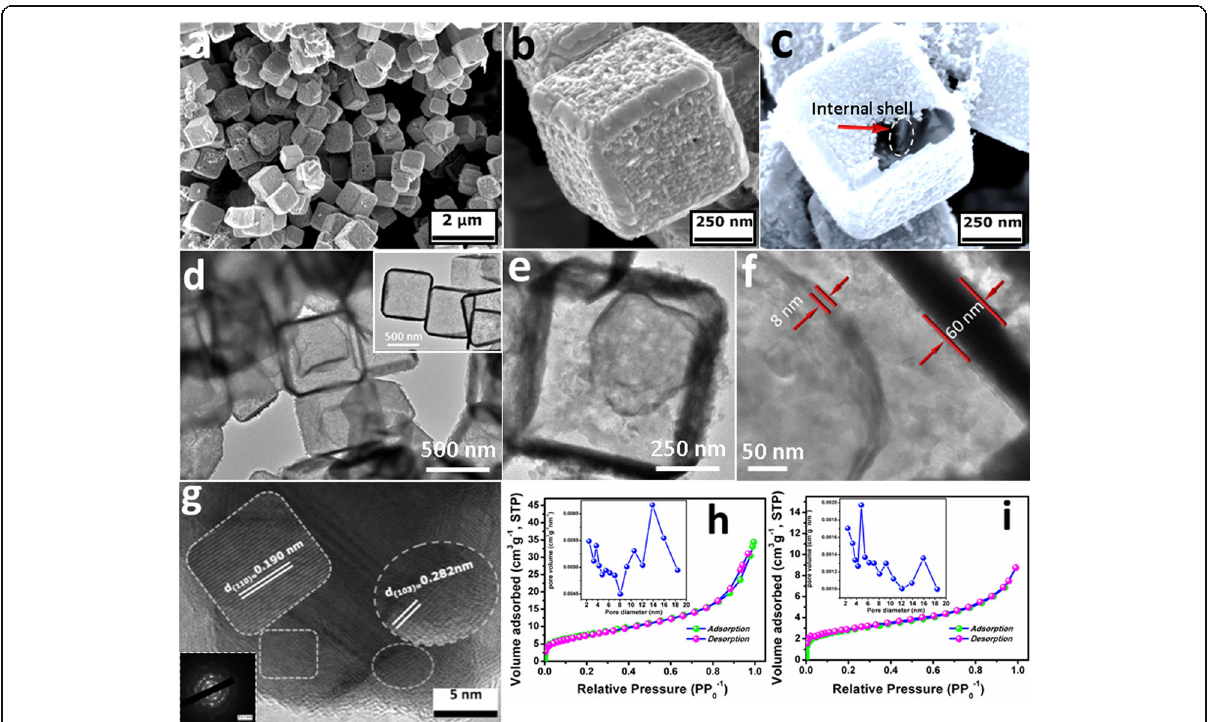
Fig. 3 a – c FESEM images of 2-CuS NCs. TEM images of d – f 2-CuS NCs and (inset of d ) 1-CuS NCs. g HRTEM image of 2-CuS NCs and insert is the selected area electron diffraction pattern. N 2 adsorption-desorption isotherm of h 2-CuS NCs and i 1-CuS NCs. Insets are the corresponding pore size